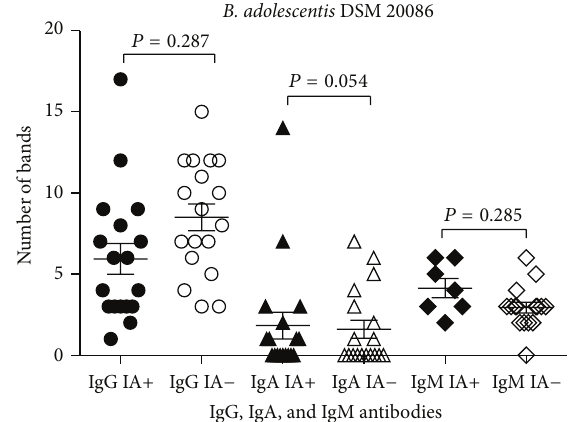
Figure 1: IgG, IgA, and IgM reactivity to B. adolescentis DSM 20083 proteins among IA-positive and IA-negative individuals.